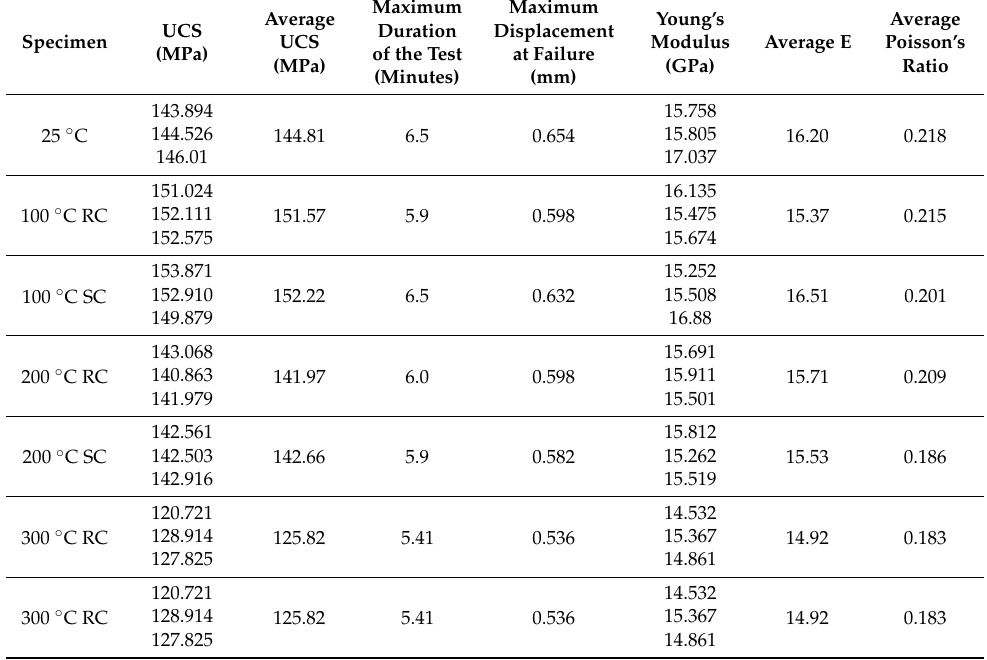
Table 3. UCS, Young’s modulus (E) and Poisson’s ratio of tested